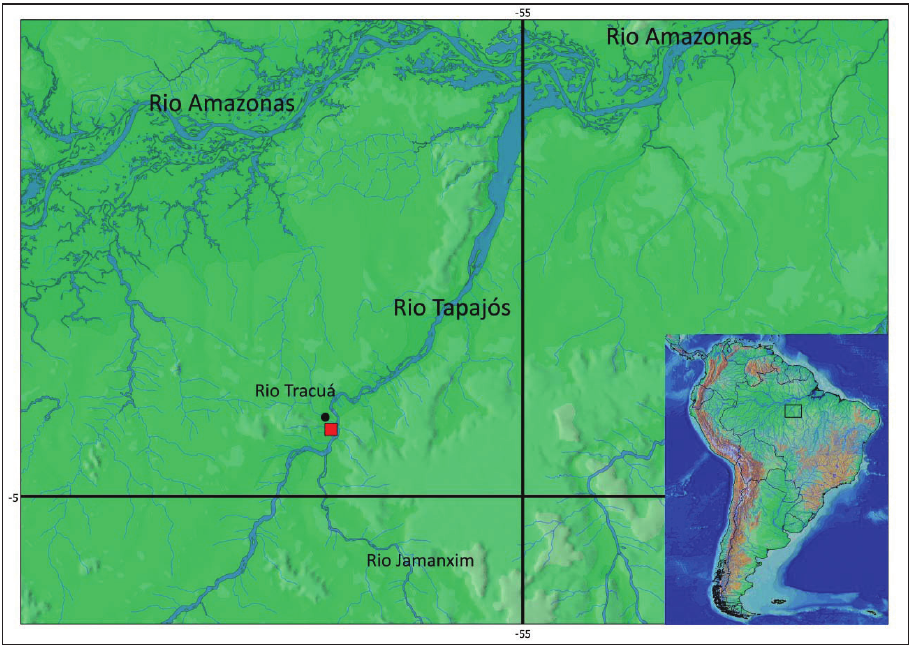
Figure 4. Map showing the type locality (red square) of Pseudancistrus zawadzkii at rio Tapajós, 04°33'09.7"S, 56°17'59.6"W, and paratype locality (black circle) at rio Tracuá, Tapajós river basin, 04°28'11.2"S, 56°17'01.1"W.